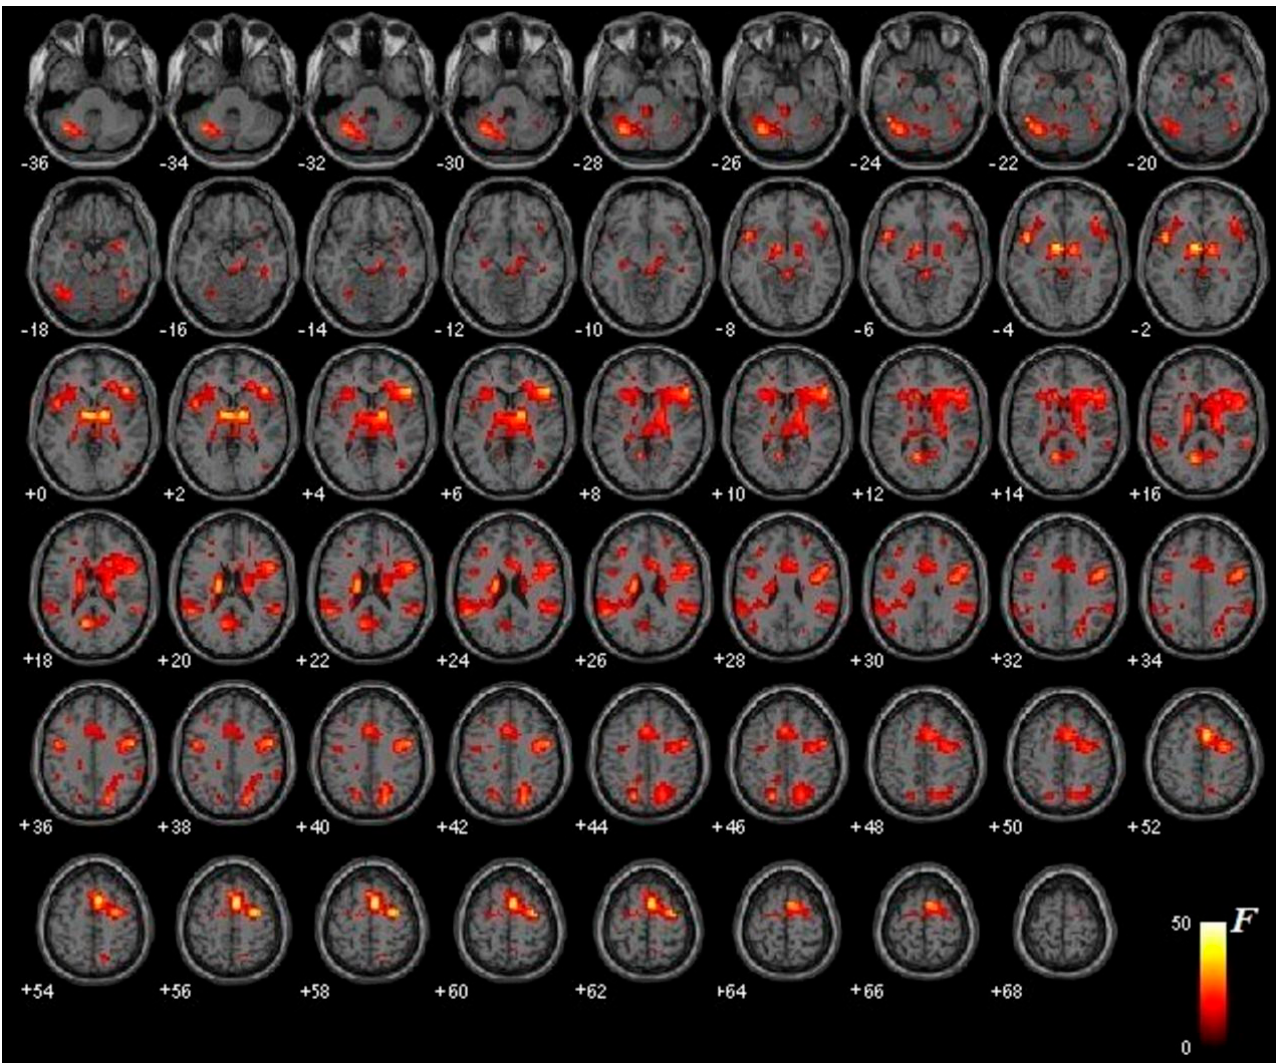
Figure 2. Main treatment effect ( p < 0.001). The figure shows the differential brain activation of all participants (intervention group and active control group) after treatment when presenting phobic stimuli (regardless of the type of image: virtual or real, depending on the group). The degree of activation ranges from red (not very intense) to white (very intense).